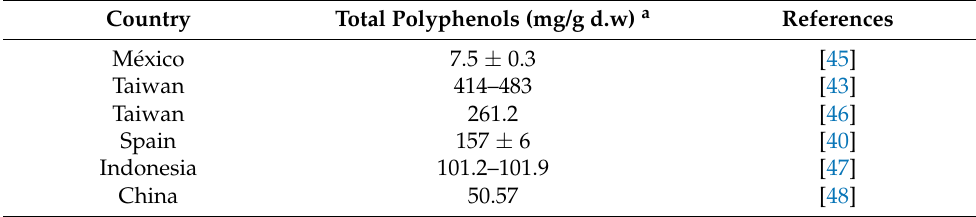
Table 2. Total polyphenol content in P. guajava L.